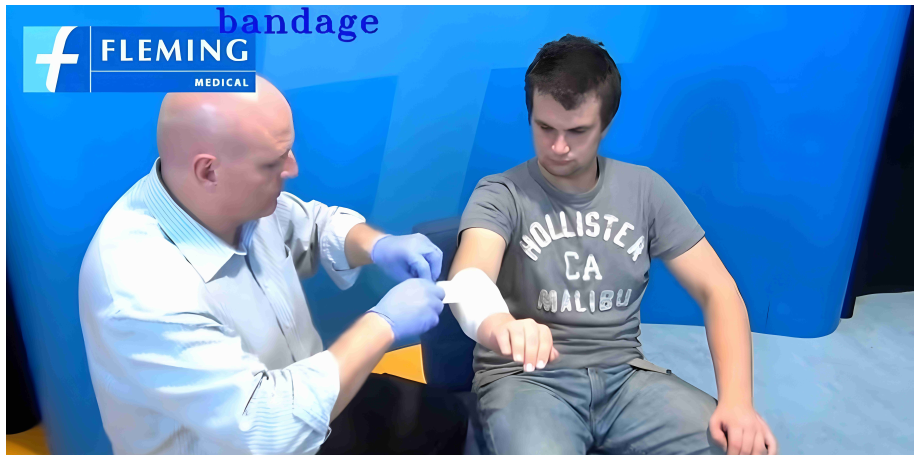
Figure 12. Bandage action recognition results in a simpler background.